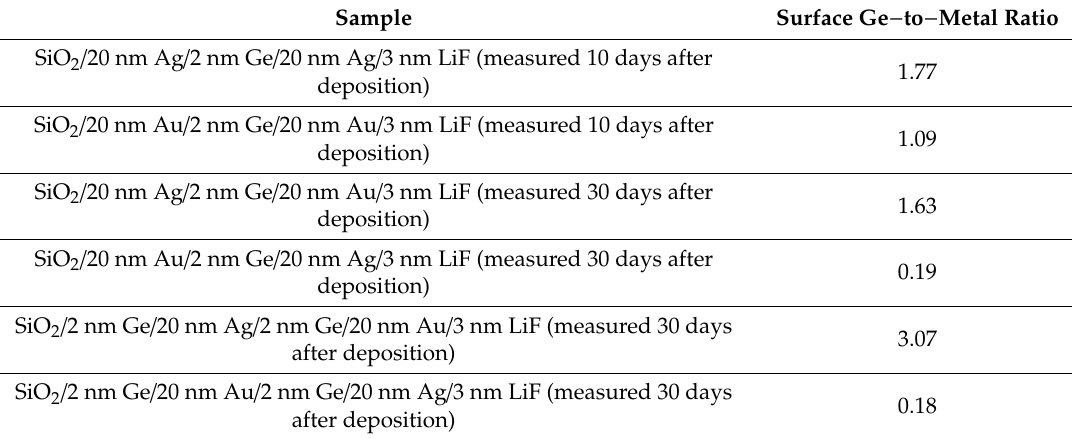
Table 1. Surface Ge-to-metal ratios calculated from the XPS spectra prior to any ion etching for all measured